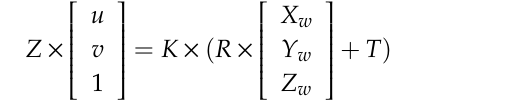
Figure 5. Results of Camera L saliency detection.